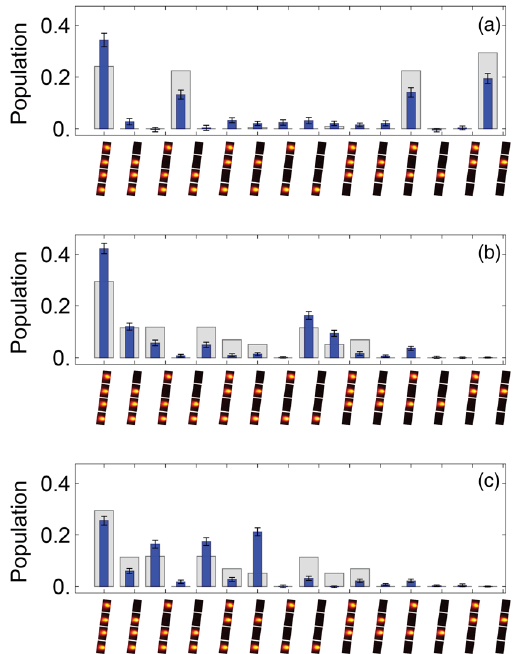
FIG. 7. Measurements when the j 0 i state is set dark (a), the jþi state is dark (b), and the j − i state is dark (c), of the prepared three- spin state after adiabatically ramping a global ð S i z Þ 2 field (narrow blue bars). The data agree closely with the calculated populations in the first excited state (gray bars), while showing little overlap with the expected populations in the ground state (wide, hatched red